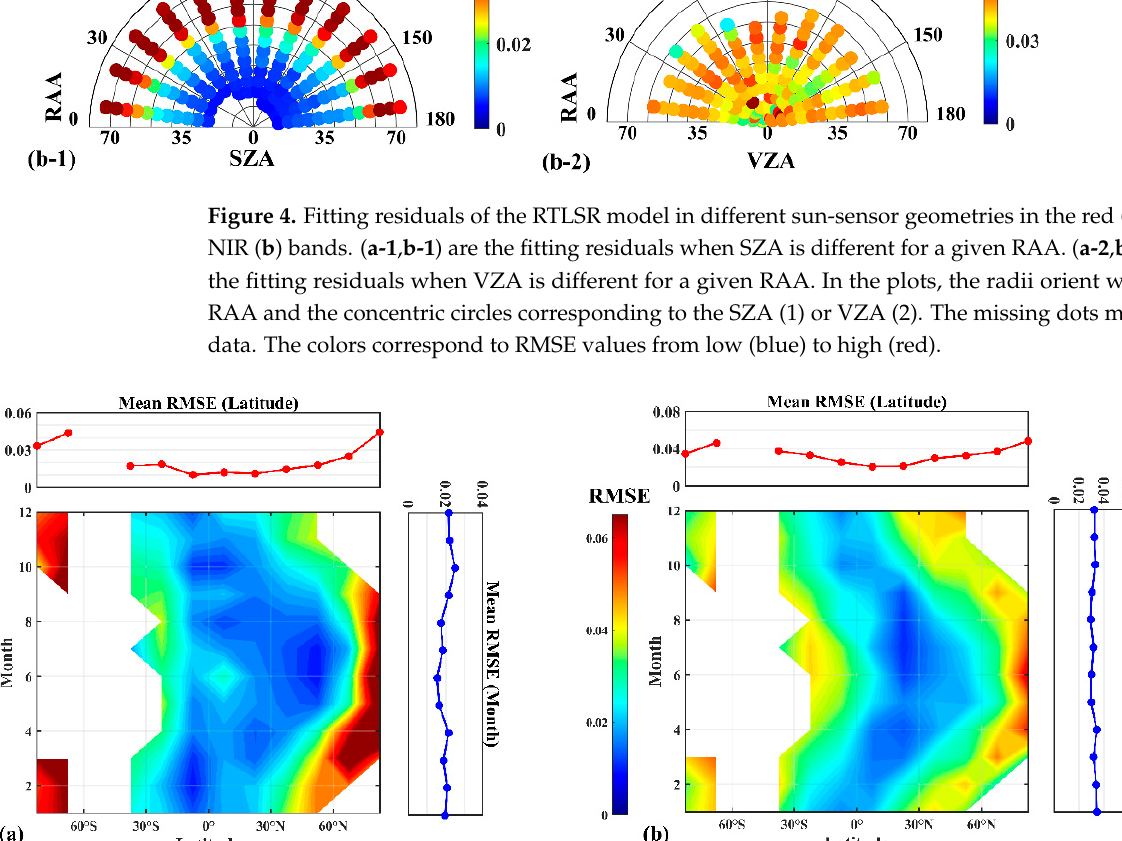
Figure 4. Fitting residuals of the RTLSR model in different sun-sensor geometries in the red ( a ) and NIR ( b ) bands. ( a-1 , b-1 ) are the fitting residuals when SZA is different for a given RAA. ( a-2 , b-2 ) the RAA and the concentric circles corresponding to the SZA (1) or VZA (2). The missing dots mean